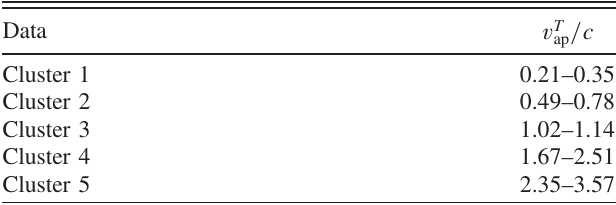
TABLE I. Summary of apparent transverse velocity for each data